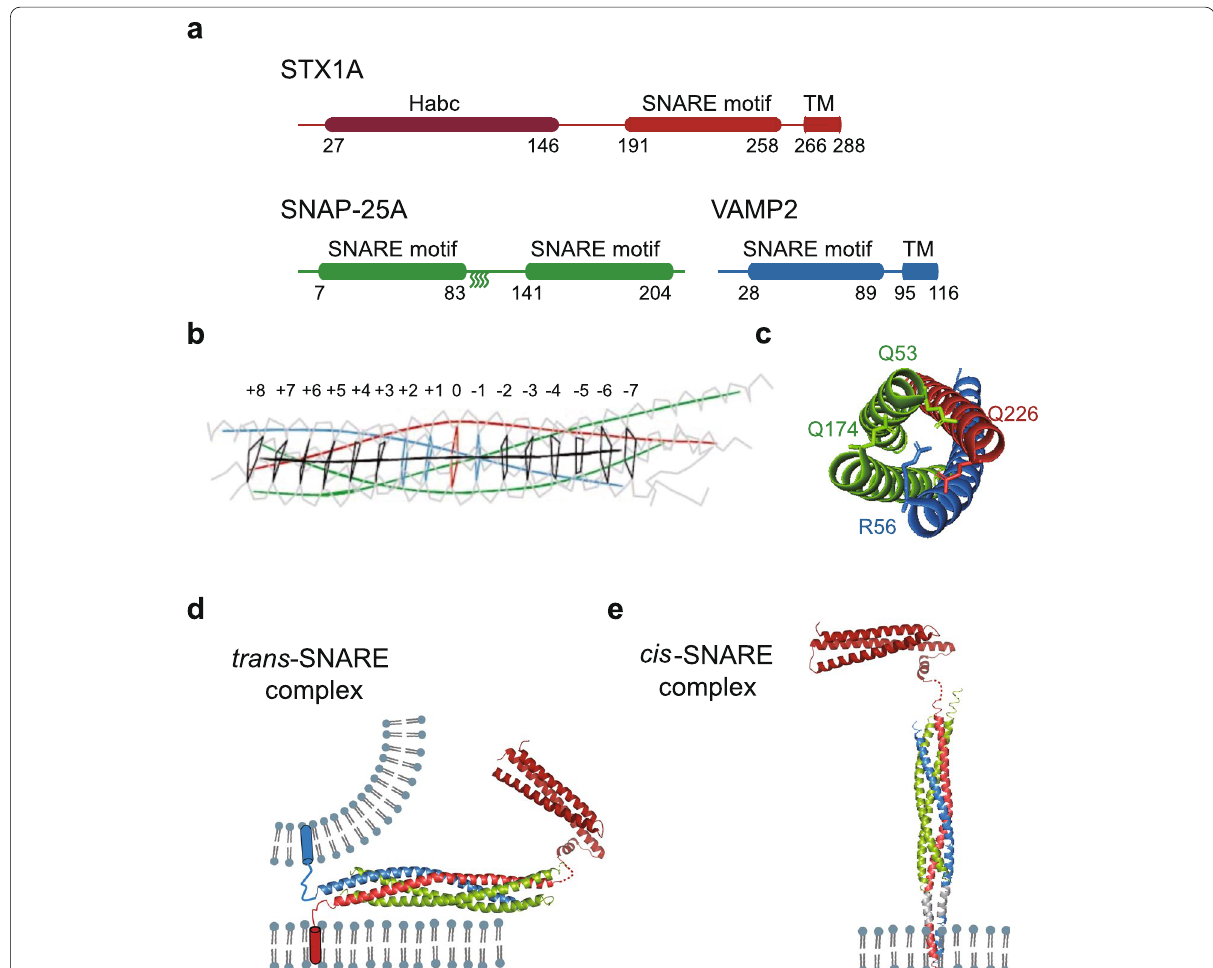
Fig. 3 SNARE proteins and SNARE complex. a Domain diagrams of the STX1A (red) with Habc domain (dark red), SNAP-25A (green) and VAMP2 (blue). For SNAP-25A, the palmitoylation sites within the cysteine cluster (C85, C88, C90, C92) of the linker region are presented as curve lines. The numbers of residues are indicated below each diagram. The color code for each SNARE protein is the same in other figures. TM, transmembrane. b 16 stacked layers (Red: 0; Blue: -1, 1 and 2, that are closest to the ideal leucine-zipper geometry; Black: others) of the SNARE complex are + + indicated in Cα traces (gray), the superhelical axis (black), the helical axes of STX1A, SNAP-25A and VAMP2 are shown as red, green, and blue respectively. c The side chains involved in the ionic “0” layer of SNARE complex are shown as sticks. d The ribbon diagram shows the structure of the trans -SNARE complex in Rattus norvegicus (PDB ID: 1SFC) [217] with STX1A Habc domain (PDB ID: 3C98) [218] on two opposing membranes. e The ribbon diagram shows the structure of the cis -SNARE complex in Rattus norvegicus (PDB ID: 3IPD) [219] on plasma membrane after a full fusion event. The copyright permission of panels b and c are from